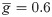
Relative root mean squared errors (RRMSE) (%) of CDS and strip transect estimators estimators (strip widths ranging from 0 to 1) of N, for 4 detection functions, with E[n] = 50, P = 0.1 and g¯=0.6.